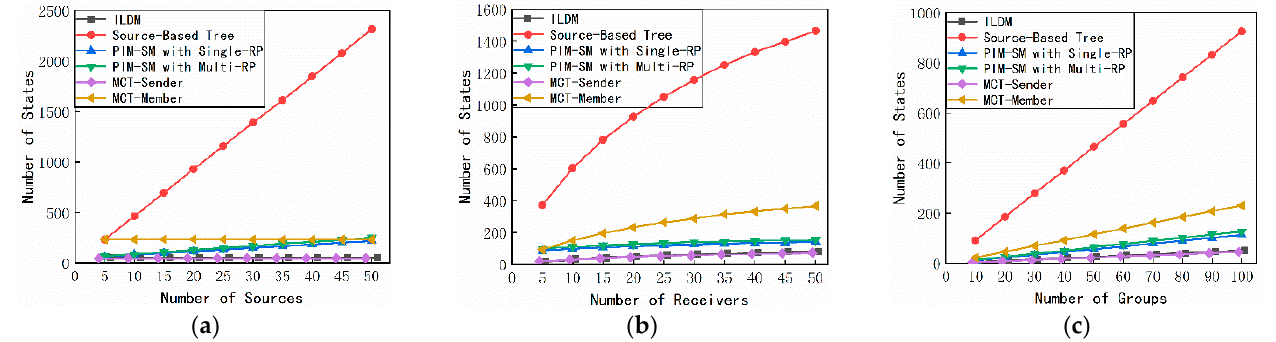
Figure 11. The comparison of the maximum number of routing states. ( a ) The variation trends of the maximum number of routing states with a different number of sources; ( b ) The variation trends of the maximum number of routing states with a different number of receivers; ( c ) The variation trends of the maximum number of routing states with a different number of groups.